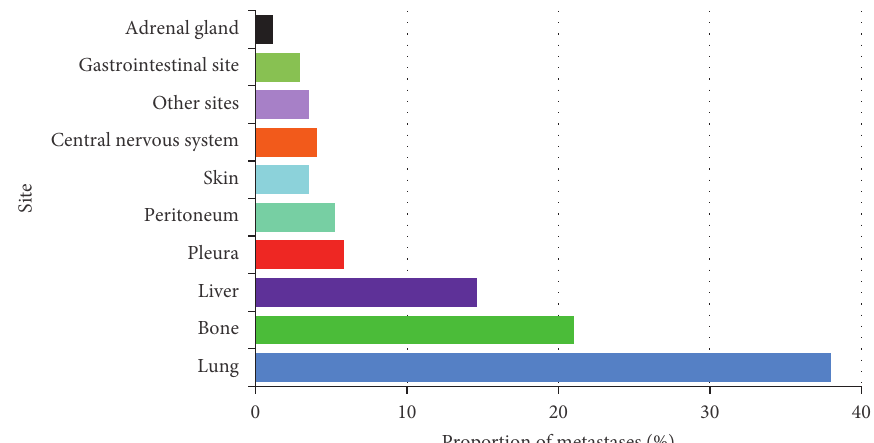
Figure 1: Most frequent metastasis sites for soft tissue sarcomas diagnosed in 2009–2012 and archived in 15 Italian population-based cancer registries.